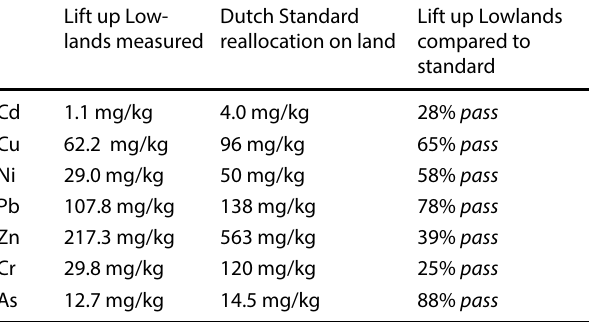
Table 1 Measured metal concentrations ‘Lift up of Lowlands’ soil compared to Dutch standard for reallocation of sediments on land